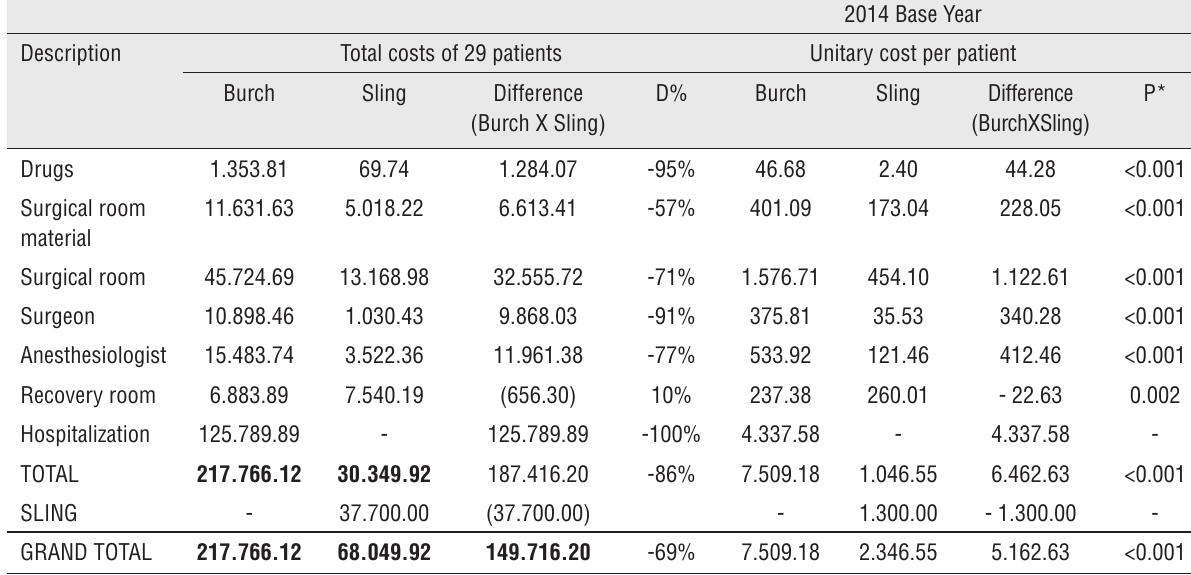
Table 2 – Comparative study of costs of Burch surgery x sub-urethral sling procedure.